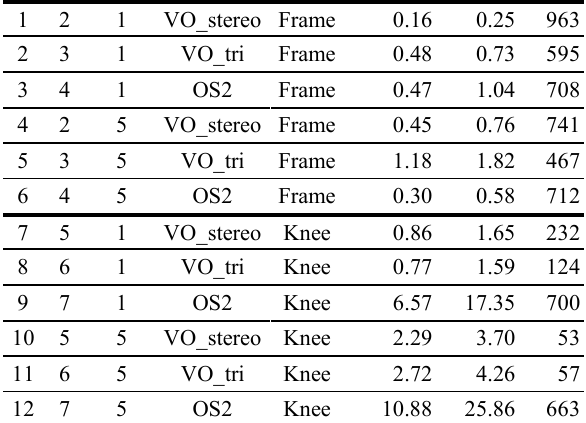
Table 2. Deviations of actual trajectories to nominal trajectories by photogrammetric bundle adjustment and used number of transformation points. First six rows represent original image sets (2, 3, 4), last six the extracted image sets (5, 6, 7) according to Table